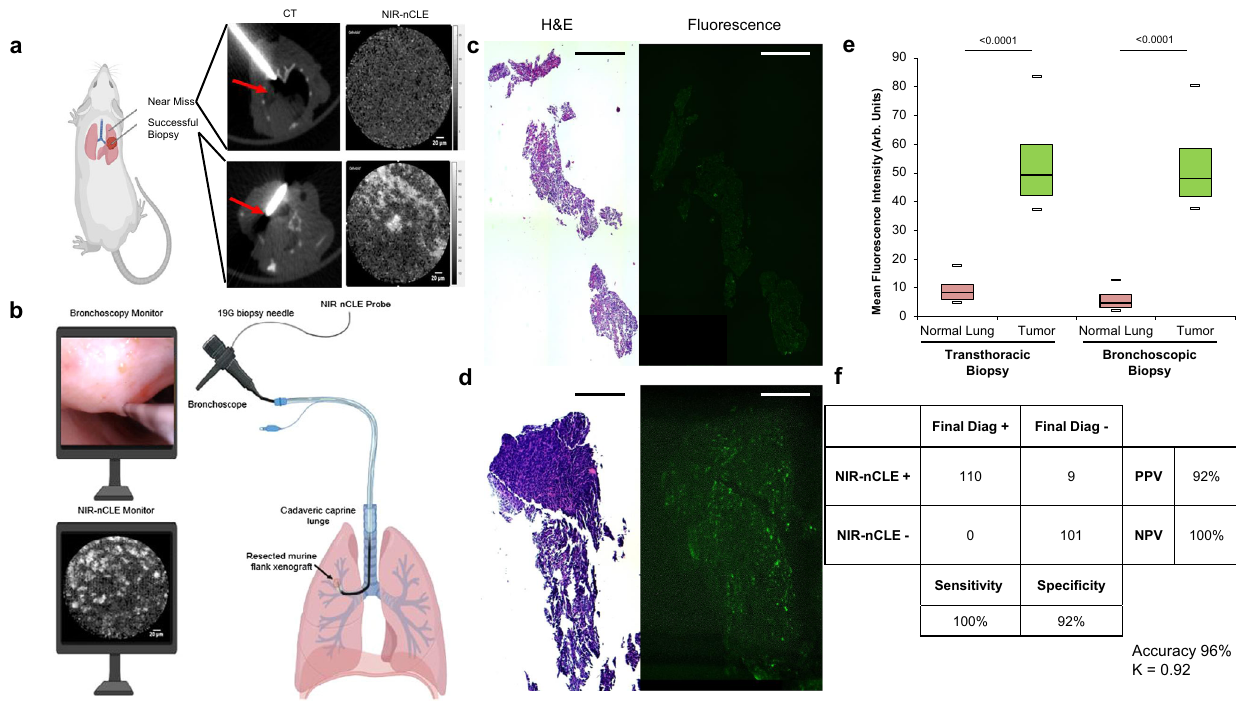
Fig. 4 NIR-nCLE can diagnoses malignancy in real-time during transthoracic and bronchoscopic biopsy of pulmonary tumors in small animal models. a Overview of the transthoracic biopsy model. Nude, athymic mice bearing orthotopic human non-small cell lung cancer xenografts ( n = 8) underwent CT- guided NIR-nCLE and biopsy. Representative CT and NIR-nCLE images of a near-miss and successful biopsy are shown with red arrow marking the tumor location. b Overview of the bronchoscopic biopsy model. Cadaveric caprine lungs ( n = 3) were implanted with murine fl ank human non-small cell lung cancer xenografts resected under pafolacianine guidance. Tumors were localized using a standard therapeutic bronchoscope and NIR-nCLE and biopsy was conducted via the working port of the bronchoscope using a 19G fl exible biopsy needle. Representative bronchoscopic and NIR-nCLE images during tumor biopsy are shown. c , d Representative hematoxylin and eosin stained biopsy slides and paired fl uorescence microscopy of normal lung and tumor, respectively. Scale bars represent 5 mm. e Mean fl uorescence intensity (MFI) of NIR-nCLE sequences taken during biopsy of normal lung and tumor tissue in the transthoracic ( n = 10 biologically independent animals) and bronchoscopic ( n = 3 biologically independent animals) biopsy models. Minima, center, and maxima of boxes represent 25th percentile, mean, and 75th percentile of MFI obtained for the entire imaging sequence. (for transthoracic biopsies n = 922 and 1408 frames for normal lung and tumor biopsy, respectively; for bronchoscopic biopsies n = 423 and 471 frames for normal lung and tumor biopsy, respectively). Whiskers represent the 5th and 95th percentile of MFI over the same sequence. Statistical comparisons were performed using two- sided t tests and p values are shown on the graph. f Diagnostic performance of NIR-nCLE sequences when analyzed by 5 non-expert raters, blinded to the fi nal histopathologic diagnosis associated with each